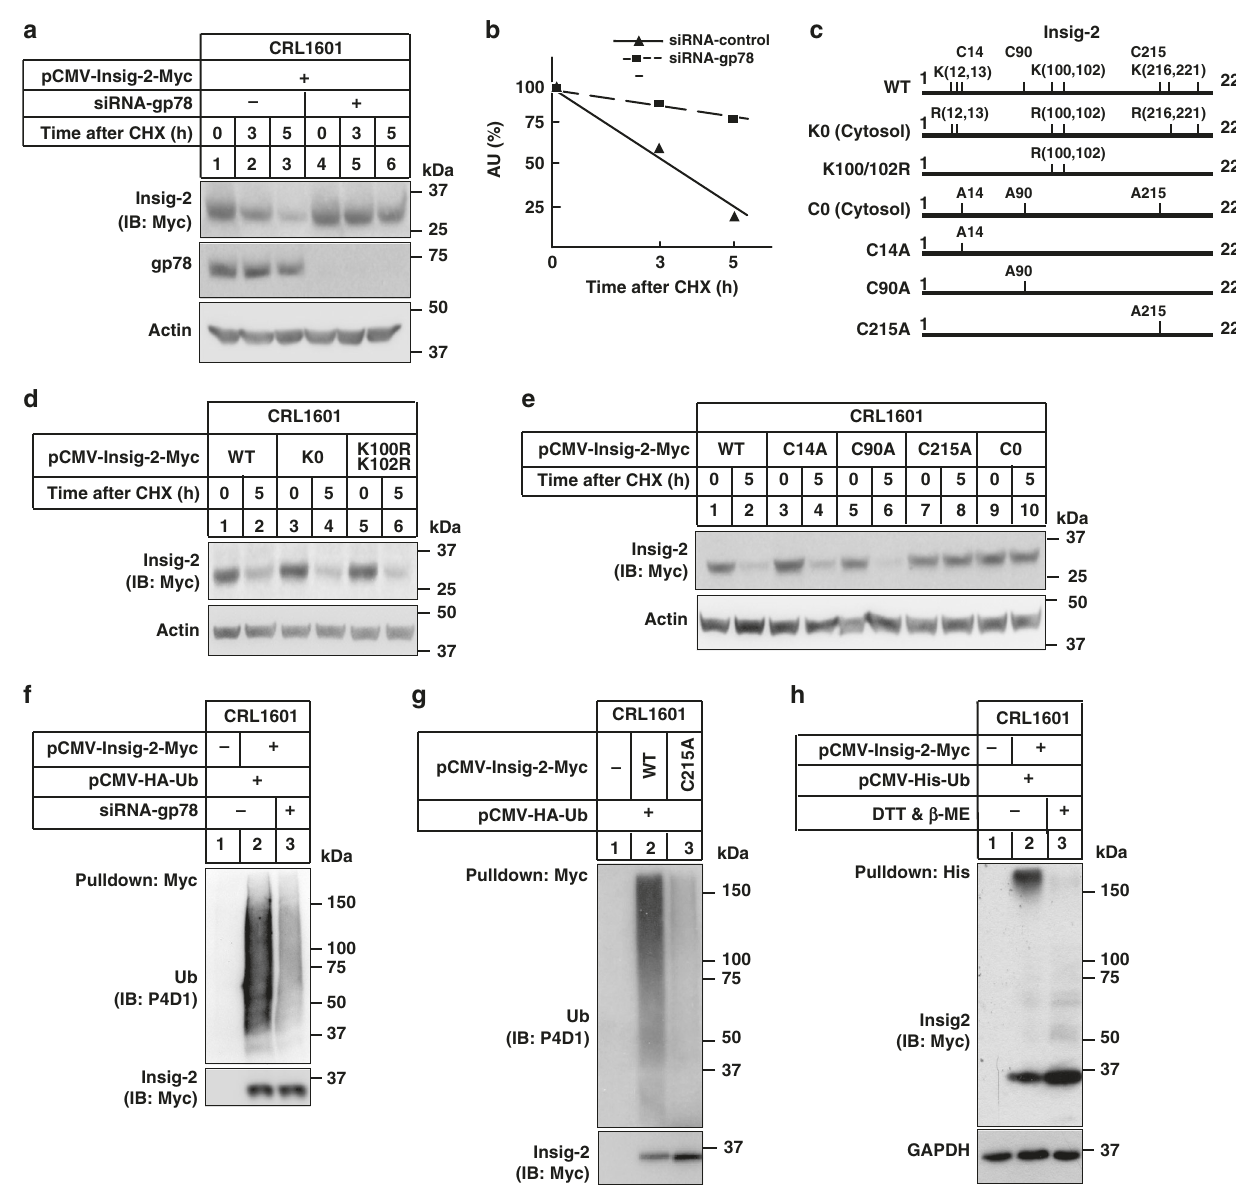
Fig. 2 Ubiquitylation and degradation of Insig-2 requires gp78 and the Cys215 residue. a CRL1601 cells were transfected with the plasmid expressing Myc-tagged Insig-2 and indicated siRNAs. Cells were then treated with 100 μ M cycloheximide (CHX) for indicated periods and harvested for immunoblotting analysis. b Densitometric analysis ( n = 3 independent quanti fi cation) of Insig-2 levels in ( a ). AU arbitrary unit. c Schematic of human Insig- 2 protein and various mutants. d , e CRL1601 cells were transfected with plasmids expressing different Insig-2 variants in ( c ), and then treated without or with 100 μ M CHX for 5 h followed by immunoblotting analysis. f CRL1601 cells were transfected with indicated plasmids and siRNAs, and treated with 10 μ M MG132 for 5 h. Cells were harvested for ubiquitylation assay. g CRL1601 cells were transfected with indicated plasmids and treated with 10 μ M MG132 for 5 h. Cells were harvested and lysed in denaturing IP buffer and subjected to ubiquitylation assay. h CRL1601 cells were transfected with indicated plasmids and treated with 10 μ M MG132 for 5 h. Cells were harvested, lysed in denaturing IP buffer followed by incubation with the Ni-NTA beads. Precipitates were treated with ( + ) or without ( − ) DTT (75 mM) and β -ME (1.5%) prior to immunoblotting